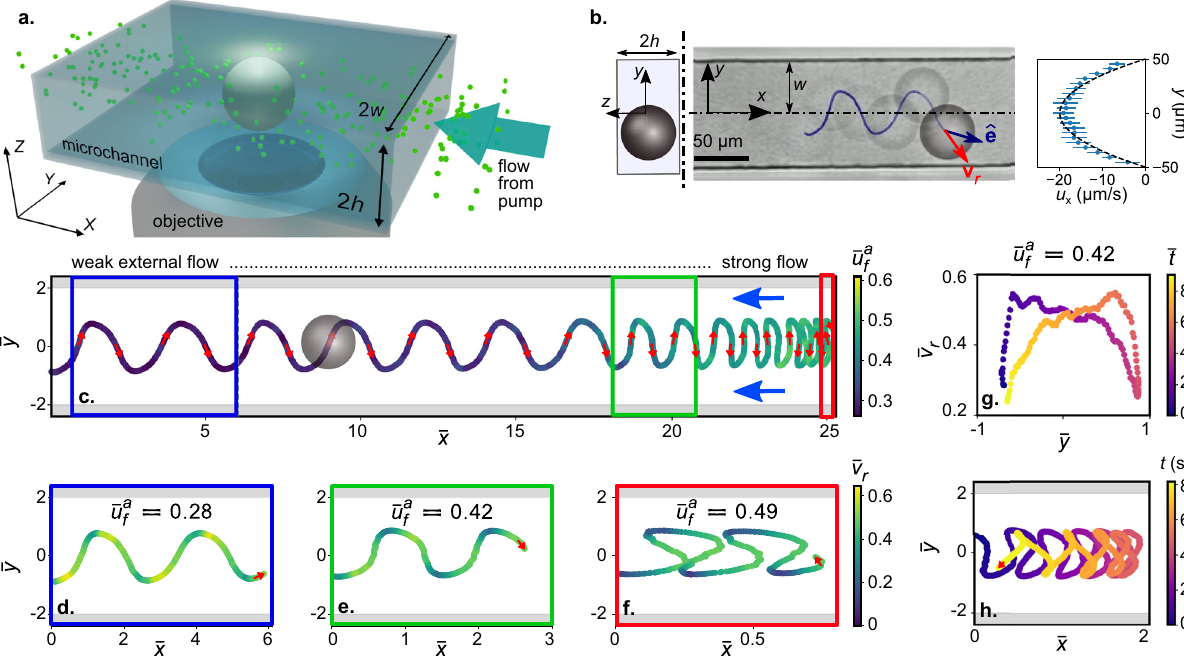
Fig. 1 Oscillatory upstream (positive) rheotaxis of an active droplet in a microchannel for increasing strength of an imposed pressure-driven fl ow. a Microscopy setup schematic showing the active droplet in a narrow microchannel with height ≈ 52 μ m (droplet diameter 2 R d ≈ 50 μ m). b Time-lapse superposition from bright- fi eld microscopy, showing the active droplet oscillating upstream, with a blue line tracking the droplet centroid. Right side: PIV- measured velocity pro fi le in the plane of oscillation for the imposed pressure-driven fl ow, with a quadratic fi t (dashed). Data points and error bars refer to average values and standard deviation of pro fi les measured along x . c The oscillatory rheotactic trajectory of the active droplet under increasing imposed fl ow, colour coded by the non-dimensional average fl ow velocity (cid:2) u a – f Variation in the non-dimensional rheotactic velocity (cid:2) v r over the oscillatory f . d trajectory for increasing values of (cid:2) u a f ; coloured boxes correspond to data ranges in ( c ). g Variation in (cid:2) v r with the transverse location of the active droplet over one wavelength of the oscillation for (cid:2) u a f ¼ 0 : 42, colour coded by the non-dimensional time, (cid:2) t . h Trapping of the oscillating active droplet within a region comparable to its diameter for over a minute, by adjusting (cid:2) u a f . (cid:2) dimensionalize spatial variables by R d (particularly, h (cid:1) 1), velocities by the intrinsic swimming speed v 0 ≡ ∣ v 0 ∣ ≈ 29.5 ± 2 μ m